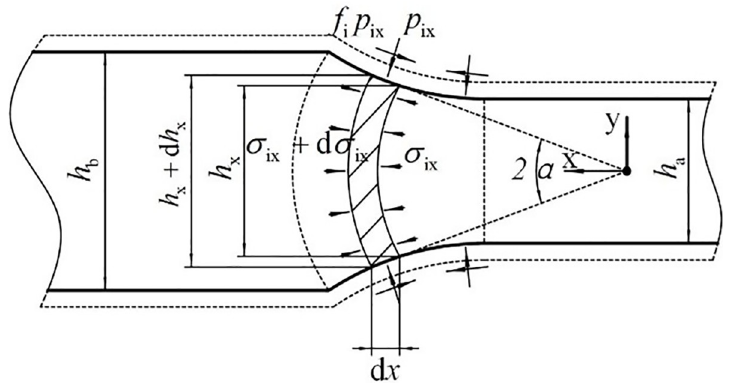
Fig 3. Stress analysis of the microunit of the core